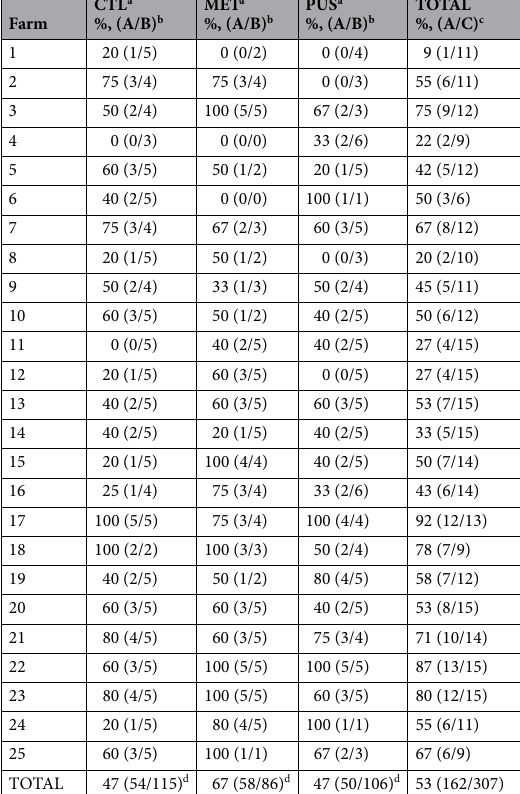
Table 1. Distribution of E. coli (n = 162) isolated from intrauterine swabs collected at 25 commercial dairy farms by clinical presentation group (CTL, MET, and PUS). A, swabs positive for E. coli ; B, total number of swabs collected from cows in clinical group; C, total number of swabs collected at each farm. a Clinical presentation of cows when intrauterine samples were collected. b Percentage, (Swabs positive for E. coli / total number of swabs collected from cows in clinical presentation group). c Percentage, (Swabs positive for E. coli / total number of swabs collected at each farm). d Percentage, (Swabs positive for E. coli / total number of swabs from all farms for cows in clinical group).